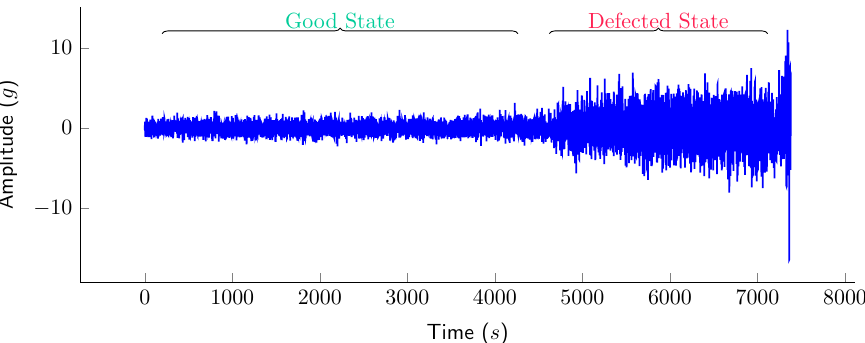
Figure 1. Vibration signals acquired for a complete run to failure of a